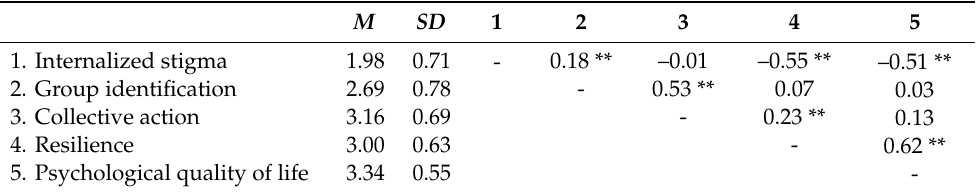
Table 1. Descriptive statistics and Pearson correlation coe ffi cients for the variables in the